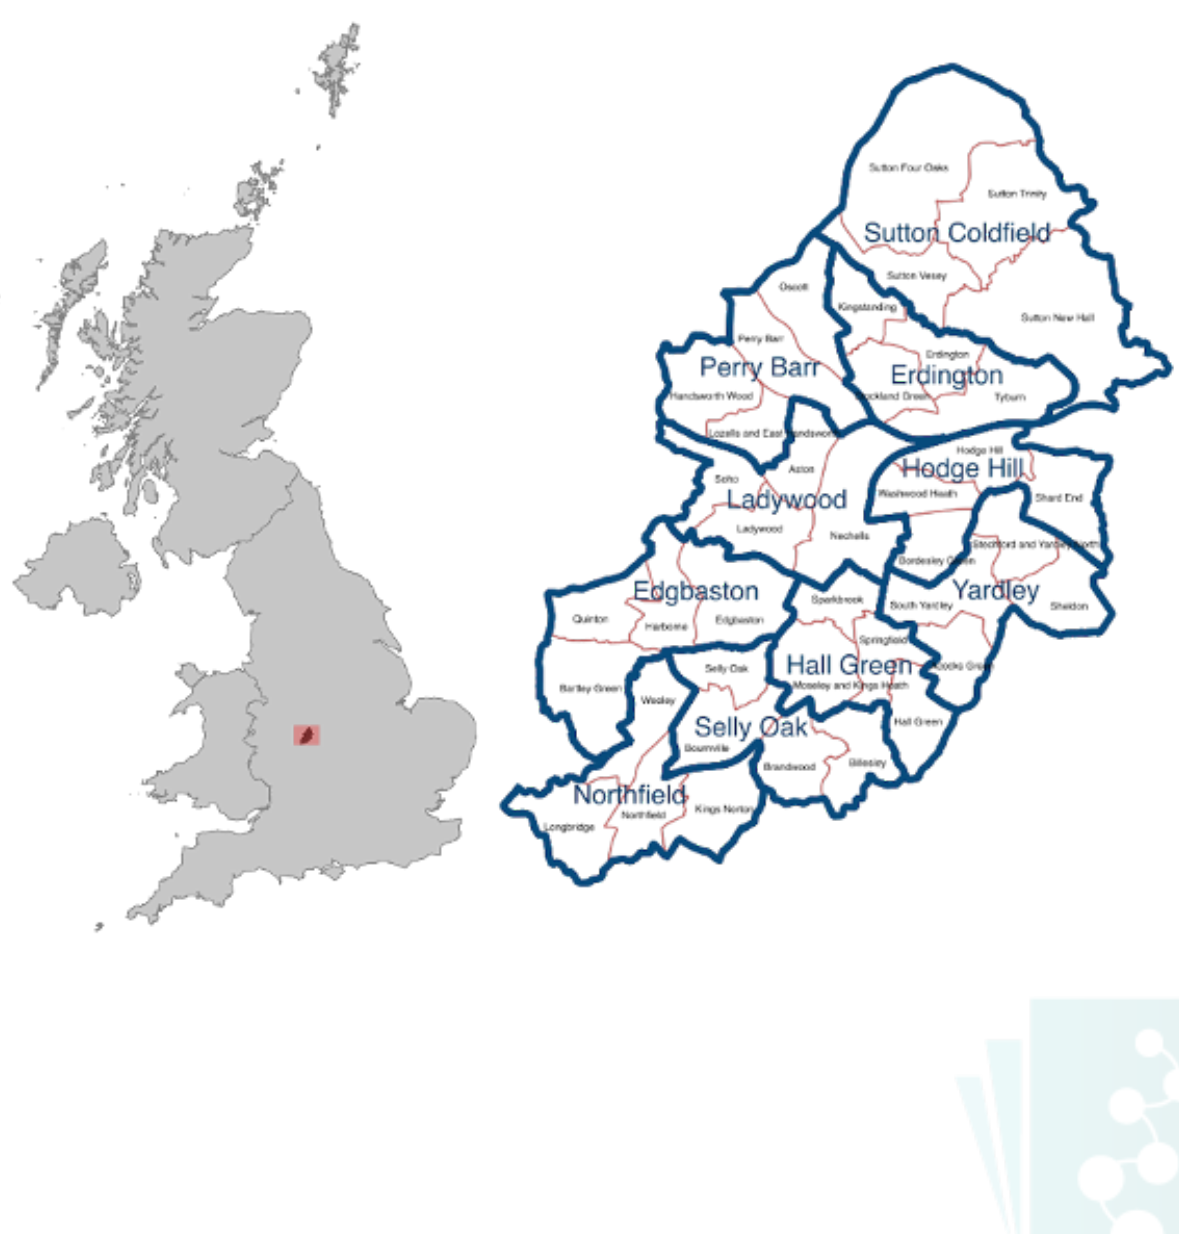
Figure 1: Birmingham and its 10 council constituencies and 40 electoral